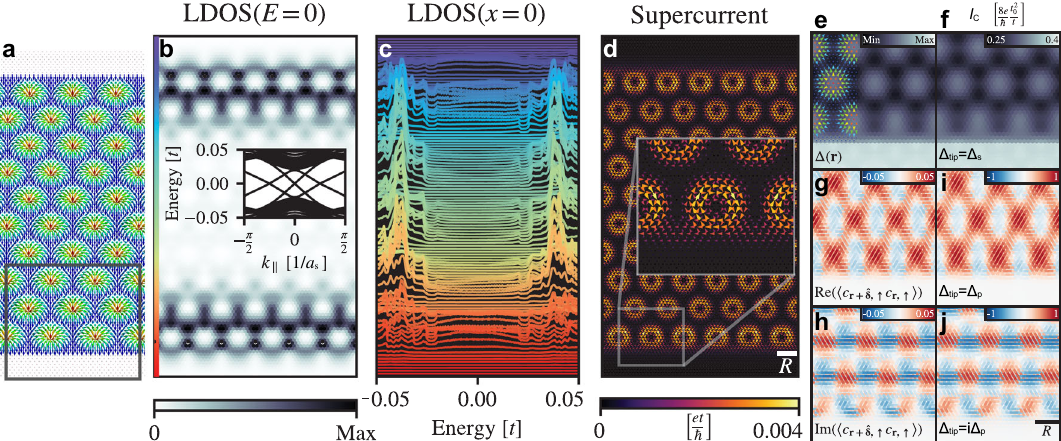
Fig. 4 MSH system with a skyrmion ribbon. a Schematic form of a skyrmion lattice ribbon on the surface of an s -wave superconductor. b Spatial plot of the zero-energy LDOS. Inset: electronic band structure as a function of momentum, k ∥ along the ribbon with a width of 27 skyrmions in the C = 3 phase. c Energy-dependent LDOS for positions from the bottom to the top of the ribbon, positions correspond to the colors at the left edge of b . d Persistent supercurrents in the skyrmion ribbon. Spatial structure of e the superconducting s-wave order parameter, Δ ( r ), and f the theoretically computed 31 critical Josephson current I c using an s -wave order parameter in the tip (shown area corresponds to black square in a ). Spatial structure of the g real and h imaginary part of the superconducting triplet correlations between nearest-neighbor sites. Spatial structure of the theoretically computed I c ( r ) with the tip possessing a i purely real and j purely imaginary triplet superconduting order parameter (see Supplementary Note 5 for details). Parameters are (JS, Δ , μ ) = (0.5, 0.4, − 5.5) t and R = 5 a 0 , corresponding to the C = 3 phase, with a width of 10